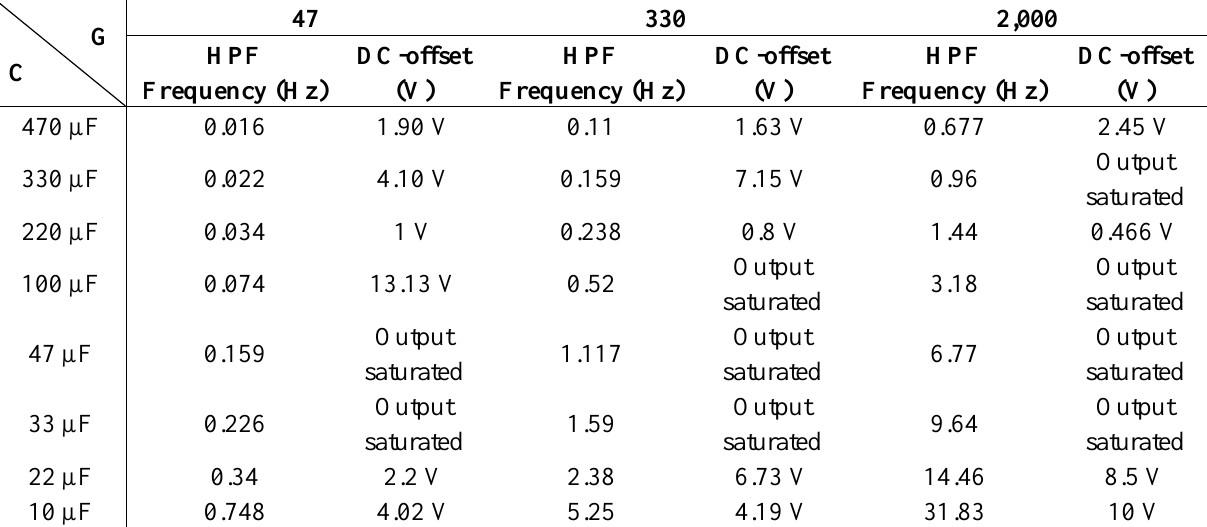
Table 2. Figure 2 output offsets and cut-off frequencies for each gain G and C